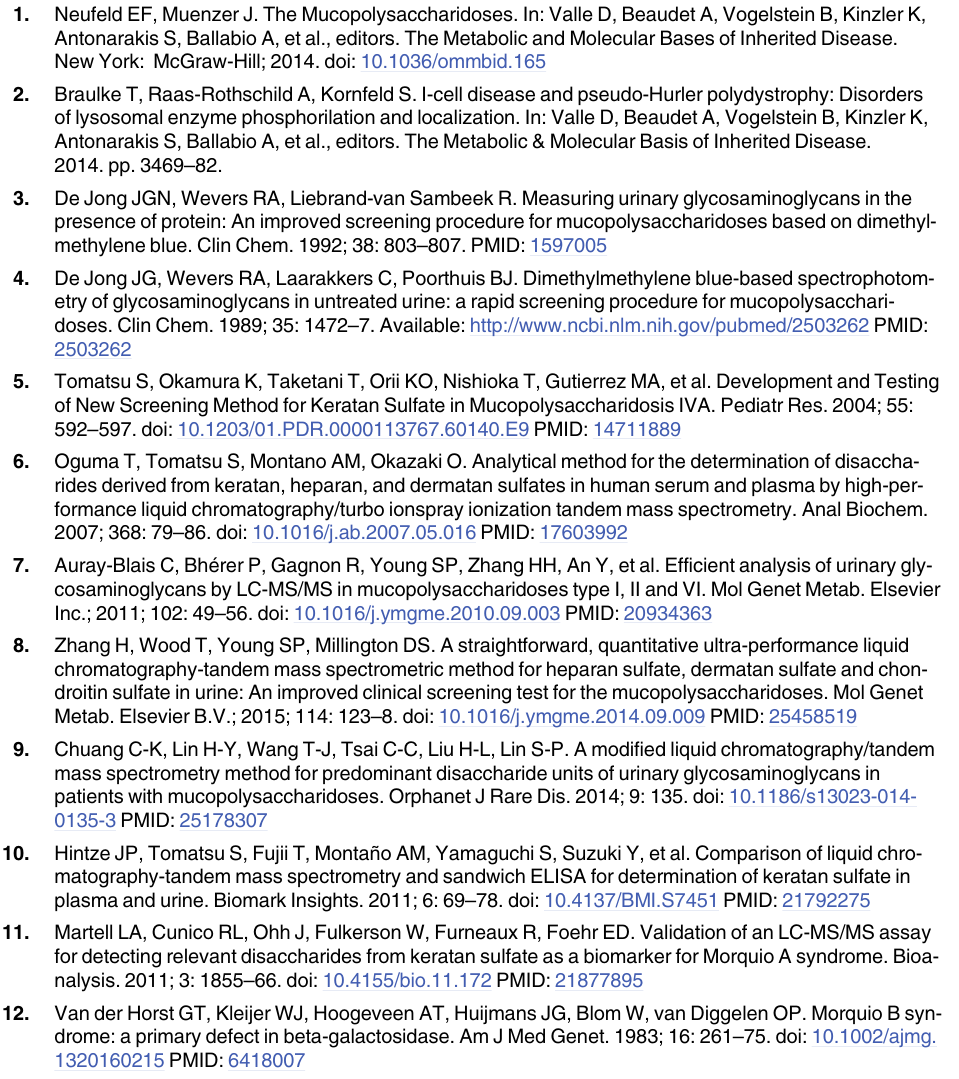
S1 Table. Upper limit of normal references for heparan sulfate, dermatan sulfate, keratan sulfate and total HS, DS and KS in urine measured by multiplexed LC-MS/MS. ULN was based on the upper limit of the 95% prediction interval of a smooth curve, fitted on the data of 61 healthy